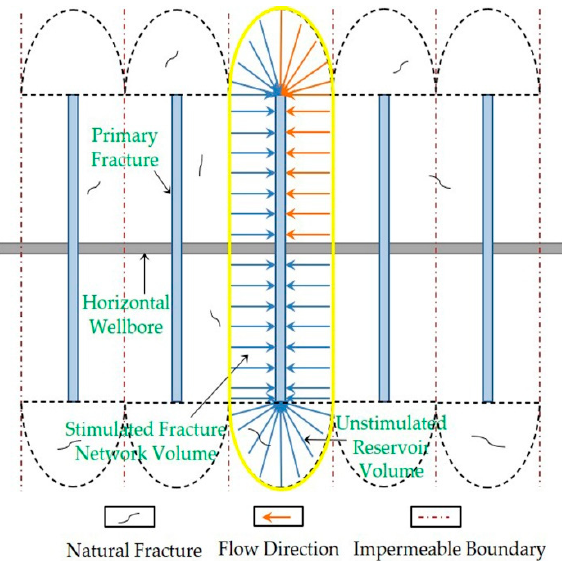
Figure 2. Three-zone composite seepage model for staged fractured horizontal well.